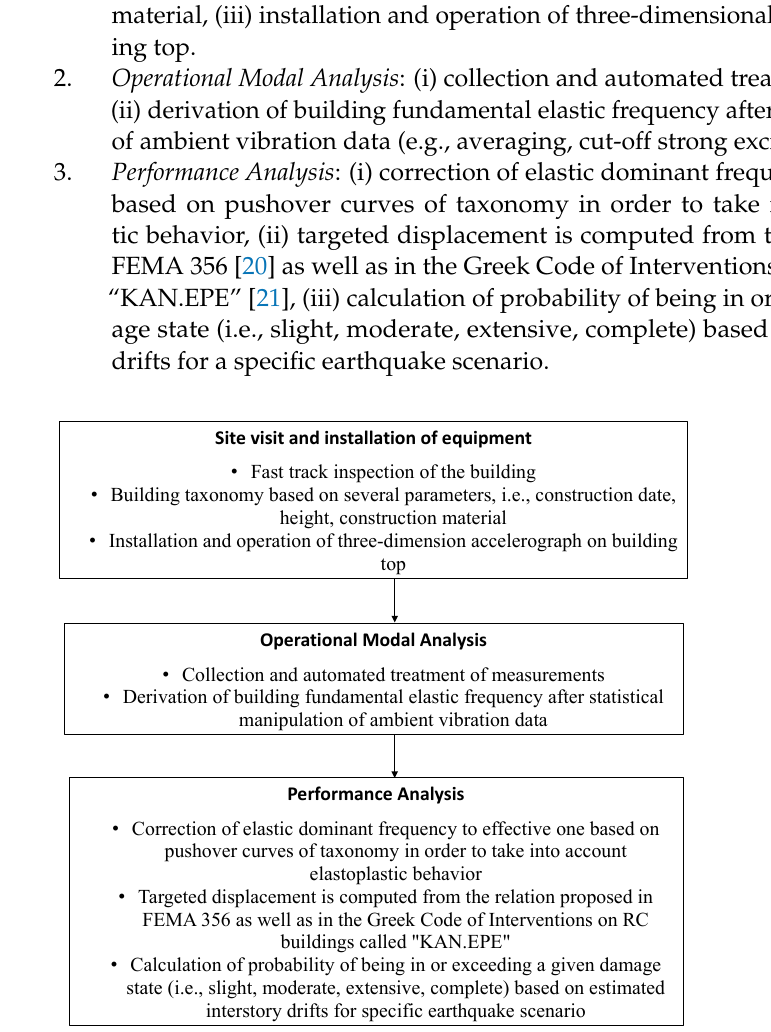
Figure 1. Flowchart of the SMSA